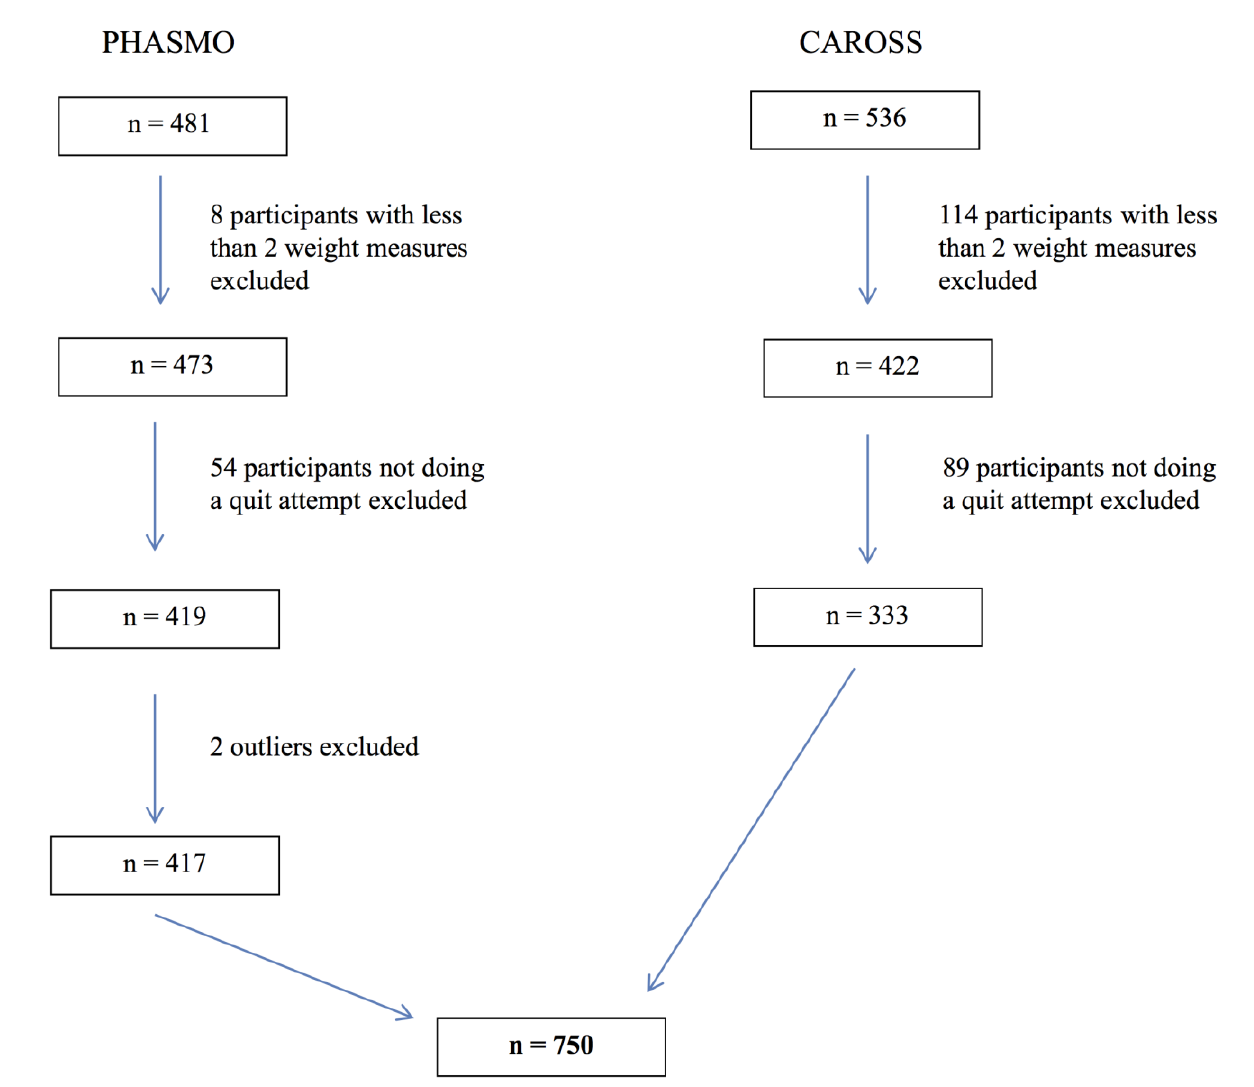
Figure 1. Flow chart of participants from both randomized controlled